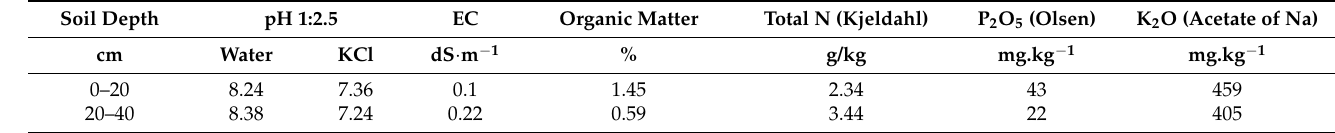
Table 1. Soil physicochemical